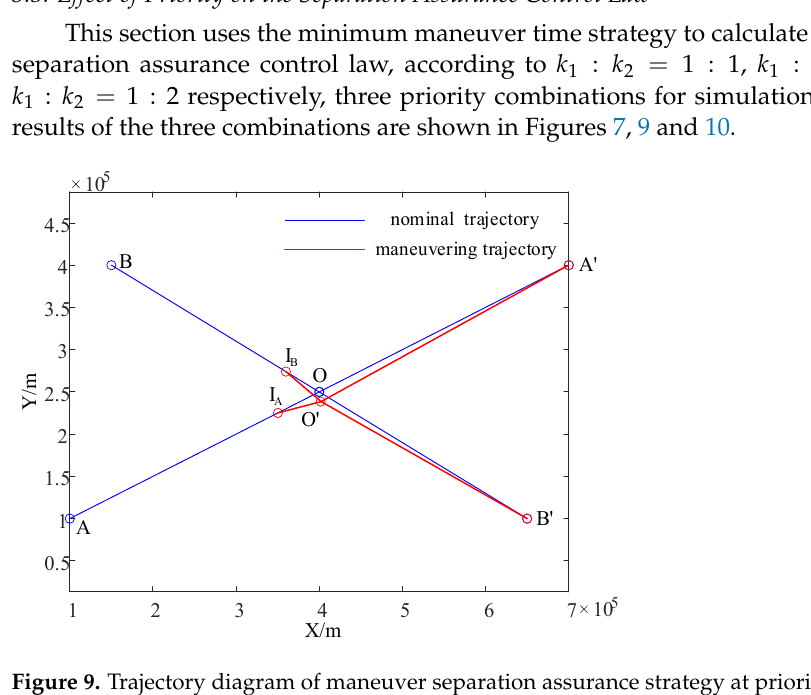
B' O' Figure 10. Trajectory diagram of maneuver separation assurance strategy at priority 1:2. Table 4. Simulation results at different priorities. Separation Assurance Strategy Aircraft One Priority: Aircraft two Priority